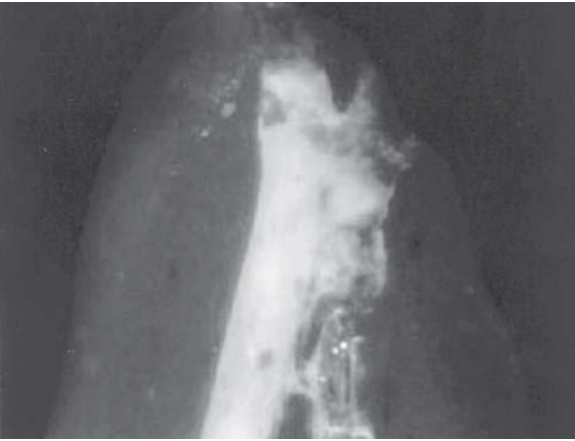
FIGURE 1- Example of score 1